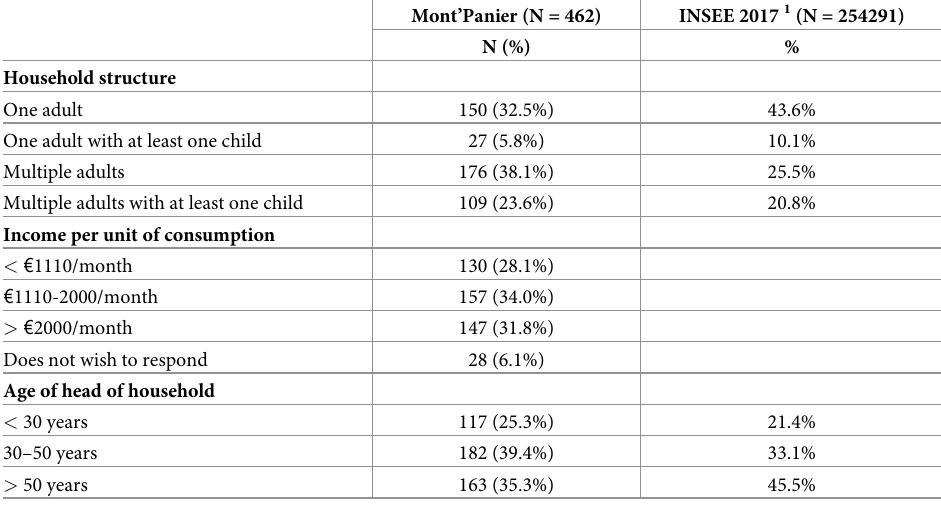
Table 1. Socioeconomic and demographic characteristics of households (N =